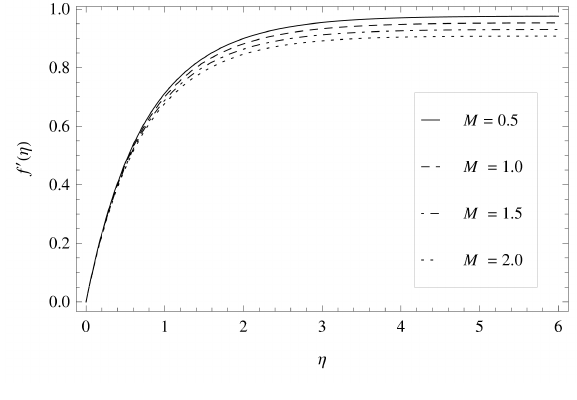
Fig. 5: The influence of a parameter M on f (cid:48) ( η ) for α = 4.5, λ = 0.1,